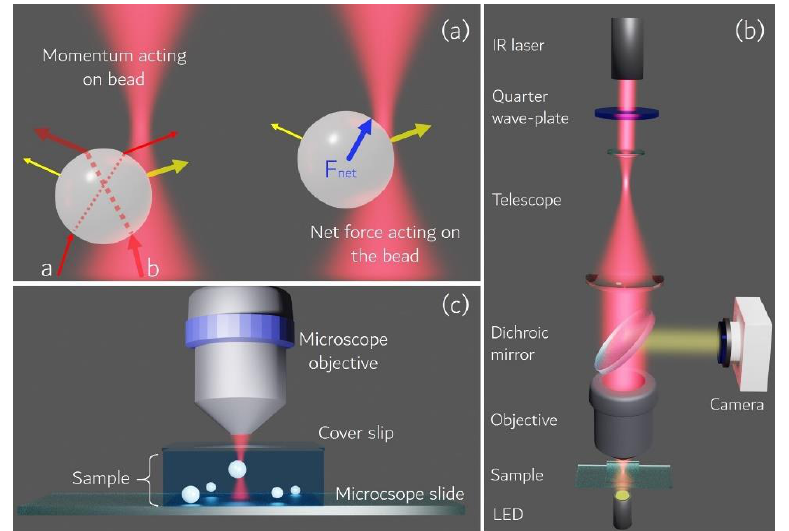
Figure 9. Optical tweezers. ( a ) An intuitive representation of the trapping process in the Mie regime. The momentum (yellow arrows) of two rays, a and b (red arrows), with different intensities propagating through a sphere is shown. The blue arrow indicates the restoring net force drawing the particle into the focal region. ( b ) Schematic of conventional optical tweezers (OT) setup—The optical trap is formed inside a sample chamber with an objective with high magnification and numerical aperture. The trapping process is imaged with a camera. (LED—Light emitting diode) ( c ) Model of the trapping process inside the sample chamber. (Reproduced with permission from [88] under Creative Commons Attribution 4.0 International License).